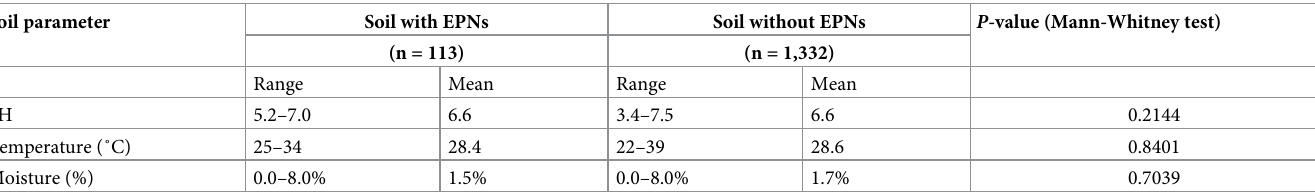
recA sequence to that of X . thuongxuanensis (95% identity) and X . eapokensis (94% identity). To confirm the species of Xenorhabdus bKK9.1_TH, five additional genes (16S rDNA, gyrB , dnaN , gltX , and infB ) were amplified and sequenced. Nucleotide sequences of four genes revealed high similarity to that of X . eapokensis : 16S rDNA and infB (99% identity), dnaN and gltX (98% identity). gyrB sequence of Xenorhabdus bKK9.1_TH showed low similarity with that of X . eapokensis (90%). The ML tree derived from all the sequences of recA among the Thai Xenorhabdus isolates and reference strains from GenBank database is shown in Fig 1. The Thai Xenorhabdus isolates were distributed in three groups. Group 1 was the majority group (60 isolates), which was closely related to X . stockiae . Group 2 contained one isolate (bKK26.2_TH), which was closely related to X . indica . Group 3 also contained one isolate (bKK9.1_TH), which fell in the clade of X . thuongxuanensis , X . ishibashii , and X . eapokensis . The ML tree derived from 16S rRNA, gyrB , dnaN , gltX , and infB genes are shown in S1–S5 Figs. The ML tree of concatenation of the five truncated genes ( recA , gyrB , dnaN , gltX , and infB ) is shown in Fig 2. All phylogenetic trees supported that Xenorhabdus bKK9.1_TH was closely related to X . eapokensis . Fifty-one isolates of Photorhabdus were identified using BLASTN search of partial sequences of the recA gene. Twenty-nine isolates were identified as P . luminescens subsp. akhurstii (97–100% identity) and 18 isolates were identified as P . luminescens subsp. hainanen- sis (98–100% identity). Two isolates were identified as P . asymbiotica subsp. australis (99– 100% identity). The remaining two Photorhabdus isolates were identified as P . luminescens subsp. laumondii (98% identity). ML analysis of 51 recA sequences of Photorhabdus distributed the isolates in three groups. Group 1 contained 47 isolates closely related to P . luminescens subsp. akhurstii and P . luminescens subsp. Group 2 contained two Photorhabdus isolates, which were closely related to P . luminescens subsp. laumondii . Group 3 contained the remain- ing two isolates of Photorhabdus , which were most closely related to P . asymbiotica subsp. aus- tralis (Fig 3).